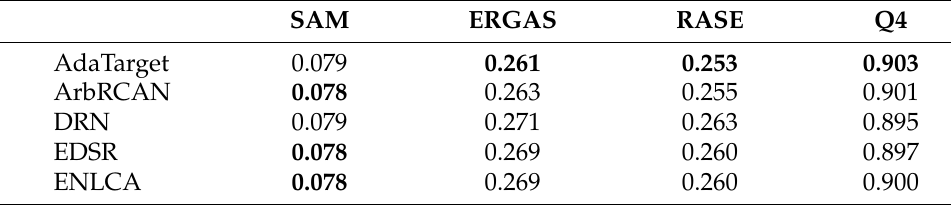
Table 4. Spectral evaluation on FY4ASRcolor with pre-trained parameters.